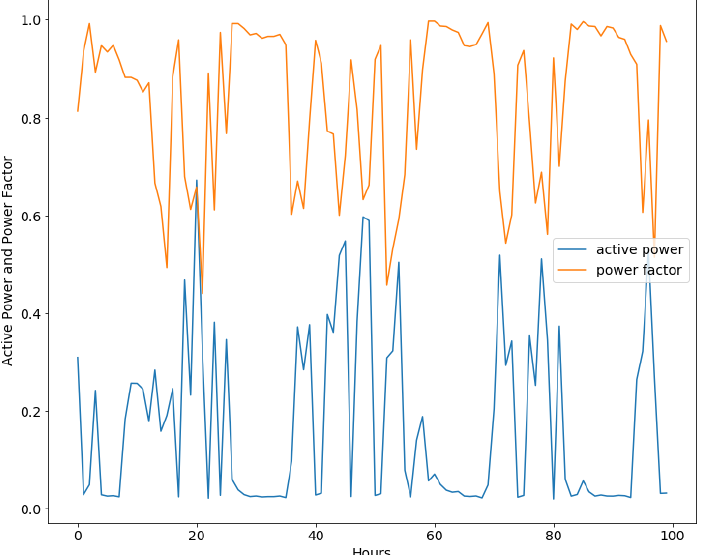
Figure 2. Relationship between active power and power factor about phase